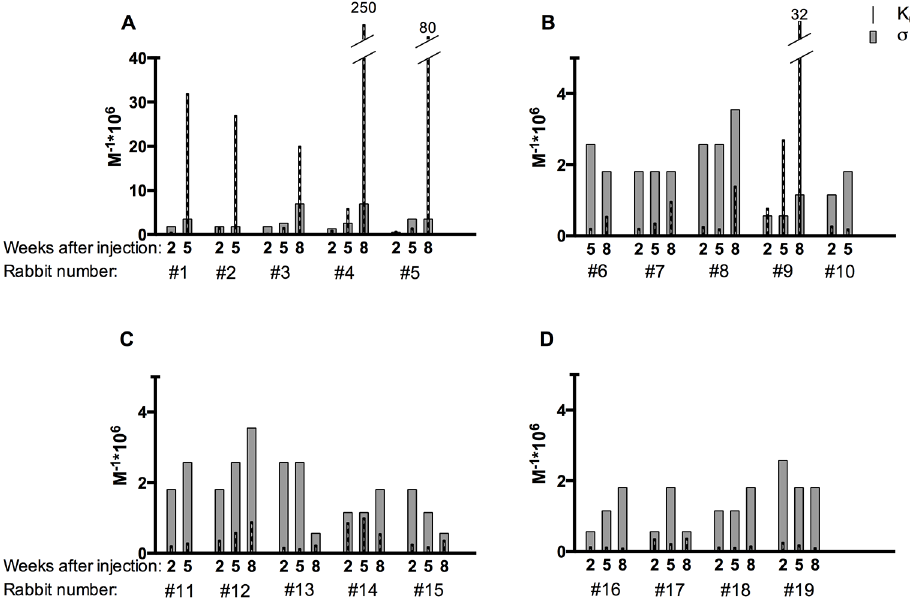
Fig 1. Mean affinity and Gaussian deviation of antibodies over time. (A) Mean affinity (K 0 ) and Gaussian deviation ( σ ) (calculated from Sips to Gaussian transformation, Karush (1964)) of antibodies isolated from serum 2 – 8 weeks after injection of 5mg of the immunogen (2,4-DNP-bovine- γ -globulin) as incomplete Freund's adjuvant in rabbits. (B) As in (A), except 50mg injection dose. (C) As in (A), except 100mg injection dose. (D) As in (A), except 250mg injection